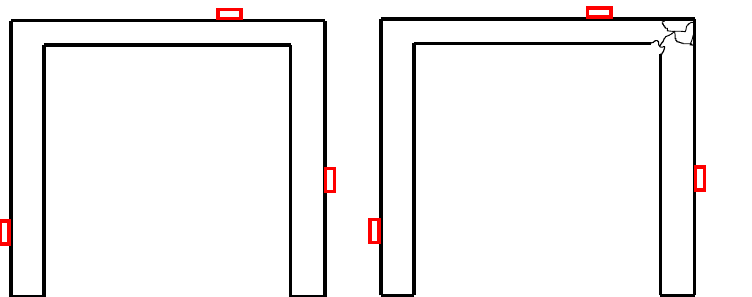
Figure 3. Schematic illustration of healthy and damaged structure. The red boxes indicate the sensors’ locations.